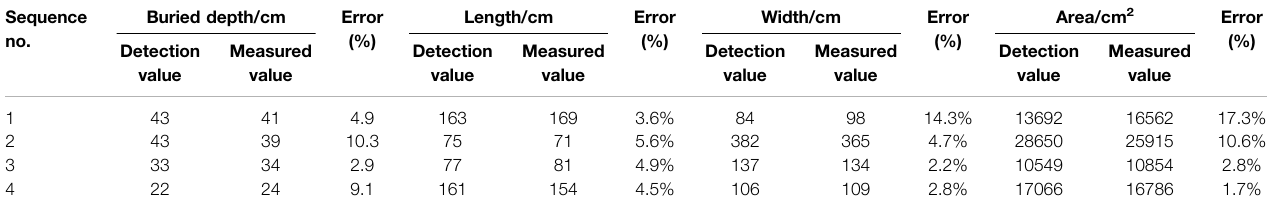
TABLE 2 | Comparison between the detected volume index and measured value of the voided internal cavity. Sequence